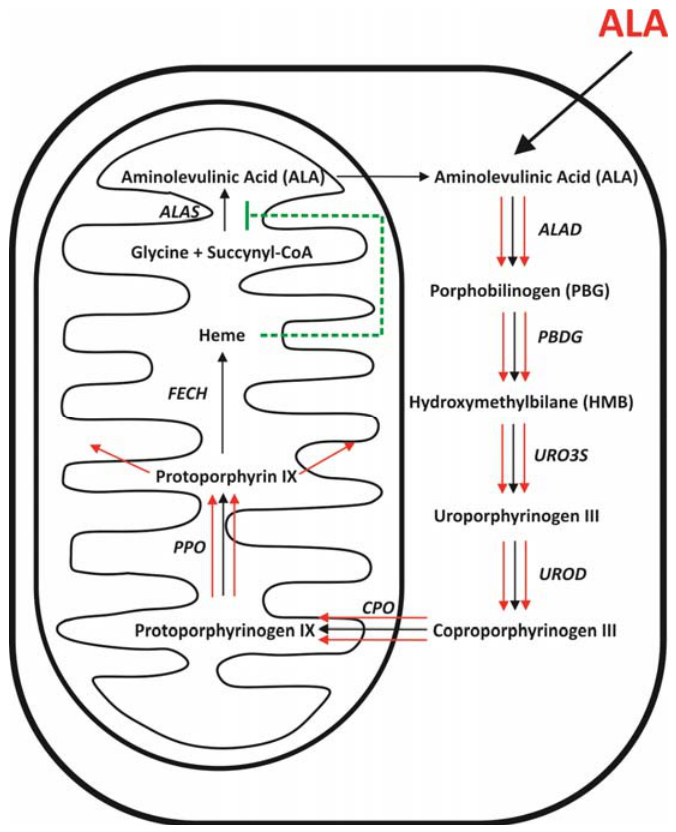
Figure 3. Heme biosynthesis. The graphic presents the most important steps in the heme biosynthetic